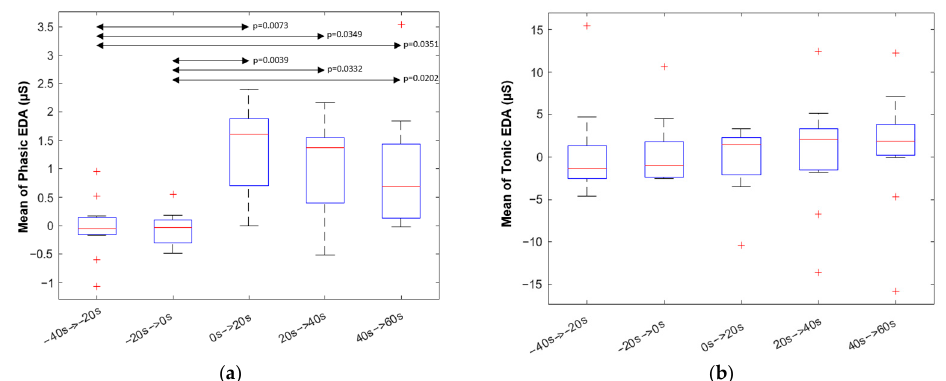
Figure 7. The boxplot of mean value of the phasic component of EDA ( a ) and tonic component of EDA ( b ) within 20 s segments starting from 40 s before the startle (umbrella) stimulus onset up to 60 s after stimulus onset. Significant differences (if p < 0.05) between segments are presented by a double arrow.